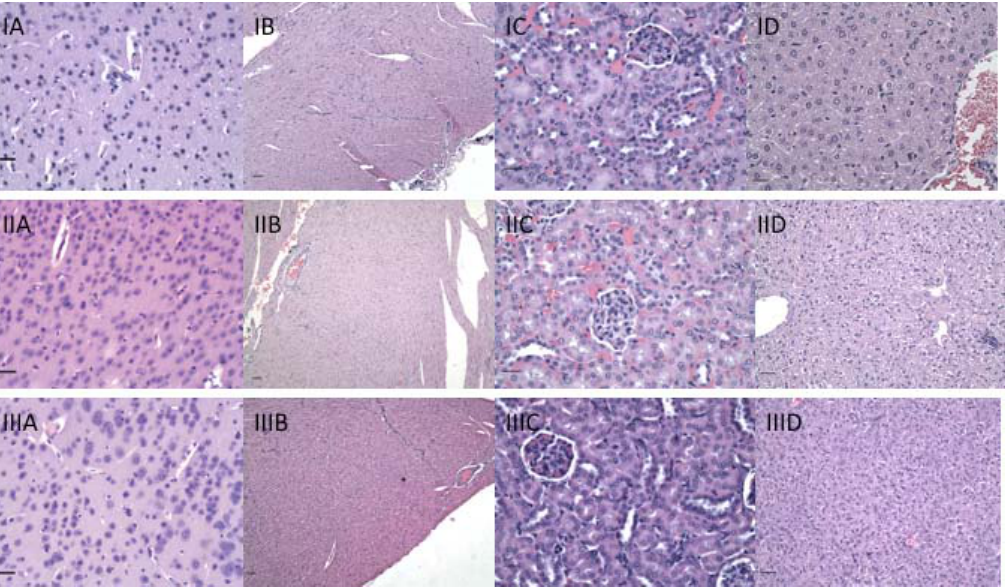
Figure 7 . H&E staining of representative organs from immunized animals exhibiting no pathologic changes. I-CMP 106; II-CMP107; III-Control. A -cerebrum, 400×, bar equals 20 µm; B -heart, 100×, bar equals 100 µm; C -kidney, 200×, bar equals 50 µm; D -liver, 200×, bar equals 50 µm.